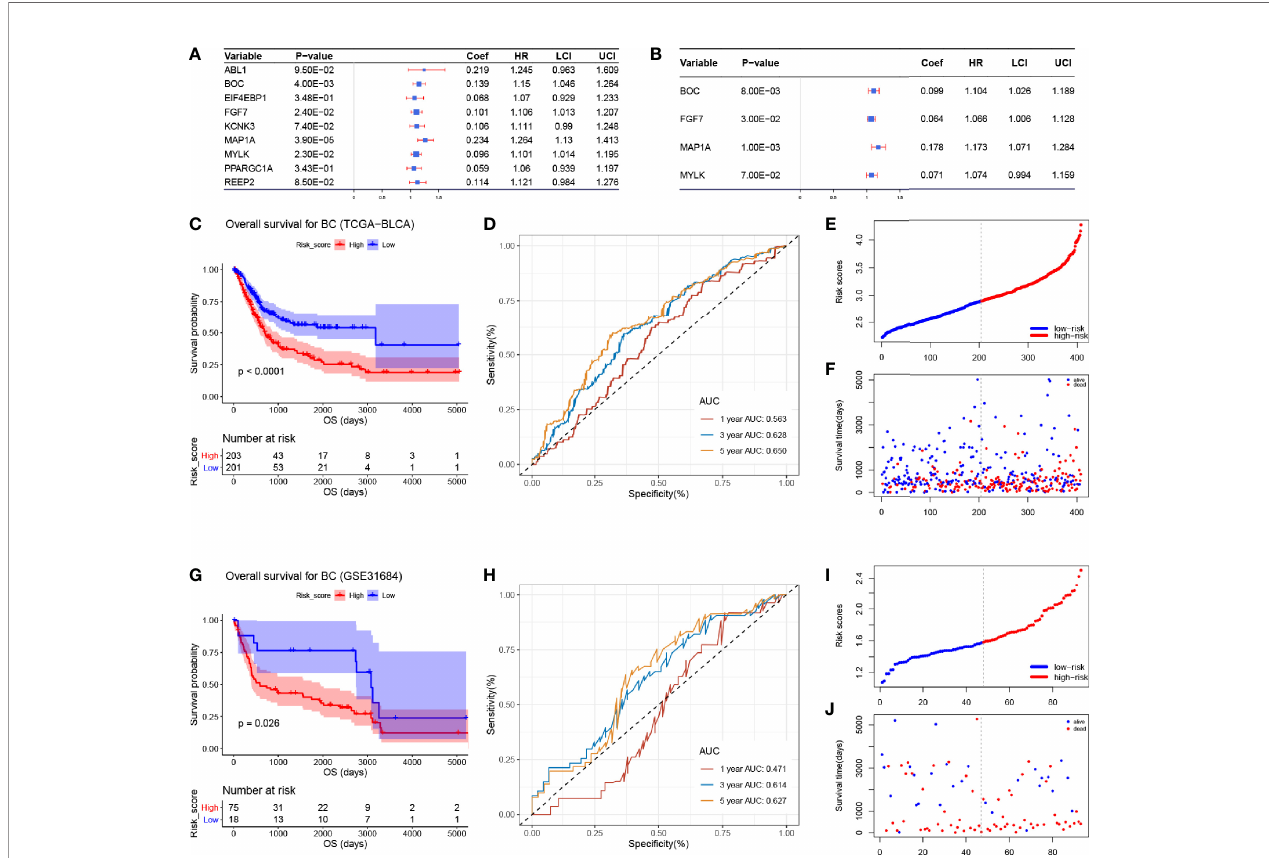
FIGURE 3 | Cox proportional hazards regression analysis and the correlation between the three-gene autophagy-related signature for OS and the prognosis of patients with BC. (A) Univariate Cox regression analysis of the nine differentially expressed autophagy-related genes. (B) Multivariate Cox regression analysis of the four autophagy-related genes. (C) Kaplan-Meier OS curves for the high- and low-risk groups by using TCGA-BLCA data. (D) ROC curve indicating the predictive accuracy of the autophagy-related signature for OS by using TCGA-BLCA data. (E) Distribution of the risk scores of BC patients based on TCGA-BLCA data. (F) The number of survivors and non-survivors with different risk scores based on TCGA-BLCA data; red represents the number of non-survivors, and blue represents the number of survivors. (G) Kaplan-Meier OS curves for the high- and low-risk groups by using GSE31684 data. (H) ROC curve indicating the predictive accuracy of the autophagy-related signature for OS by using GSE31684. (I) Distribution of the risk scores of BC patients based on GSE31684. (J) The number of survivors and non-survivors with different risk scores based on GSE31684; red represents the number of non-survivors, and blue represents the number of